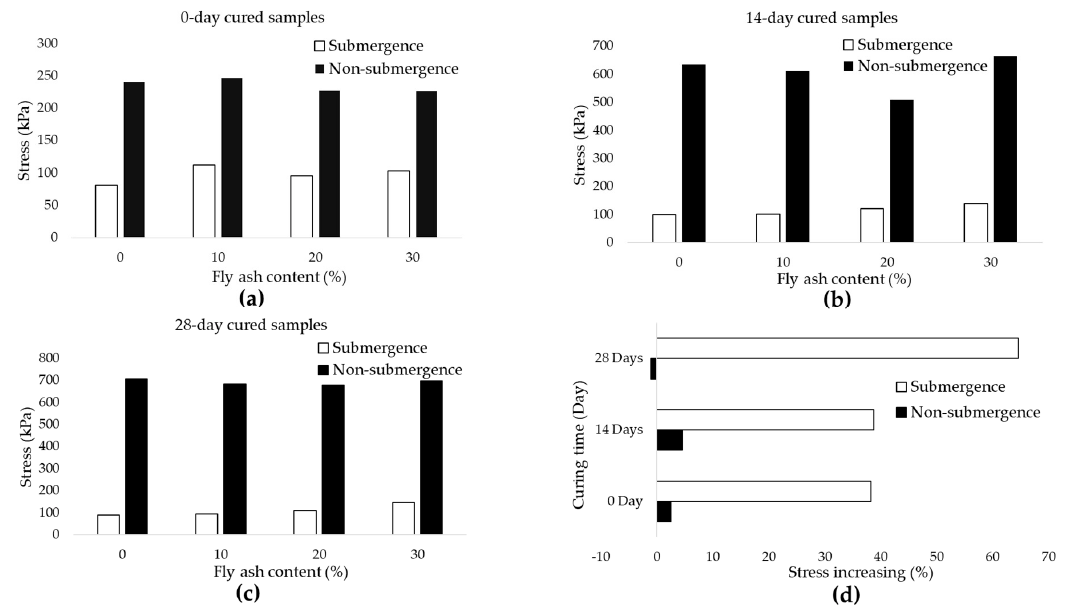
Figure 1. The influence of the variation in FA-stabilized loess (FASL) specimen on stress at different curing times under non-submergence and submergence conditions: ( a ) zero days; ( b ) 14 days; ( c ) 28 days; and ( d ) stress increasing.